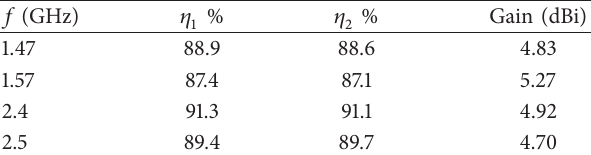
Table 2: Antenna radiation efficiency and